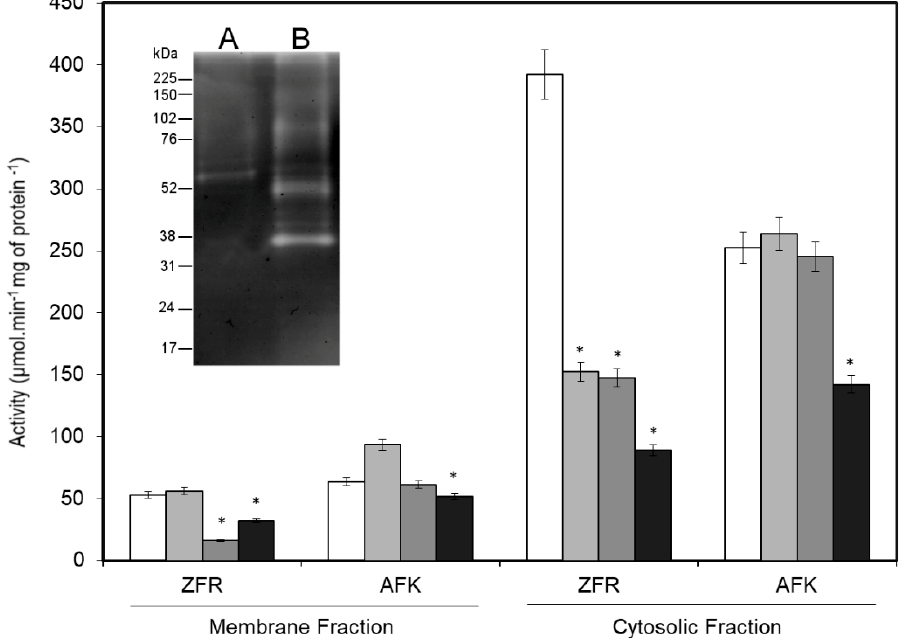
Figure 1. Serine proteinase activity in Leishmania (V.) braziliensis promastigote fractions. The enzymatic activity assays in solution were carried out with parasitic proteins (5 µg) from enriched subcellular fractions (membrane and cytosolic) by benzamidine affinity chromatography with Z-FR- AMC or Suc-AFK-AMC (0.1 mM) as the substrate in activation buffer. The activities were assessed without inhibition ( ) or in presence of 10 µM E-64 ( ), 1 mM PMSF ( ) and 5 µg aprotinin ( ). The activities (µmol·min − 1 ·mg of protein − 1 ) are represented as the average and standard deviation (±) of three independent experiments. Inset, zymographic profile of membrane ( A ), and cytosolic ( B ) fractions enriched with serine proteinase (15 µg). The molecular mass markers are indicated on the left (kDa). These results are representative of three independent experiments. * p < 0.05.